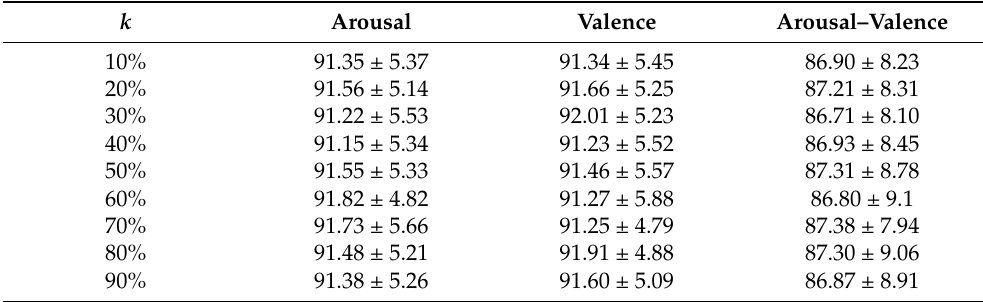
Table 1. Emotion recognition performance of GC-GCN graph features with different threshold k .